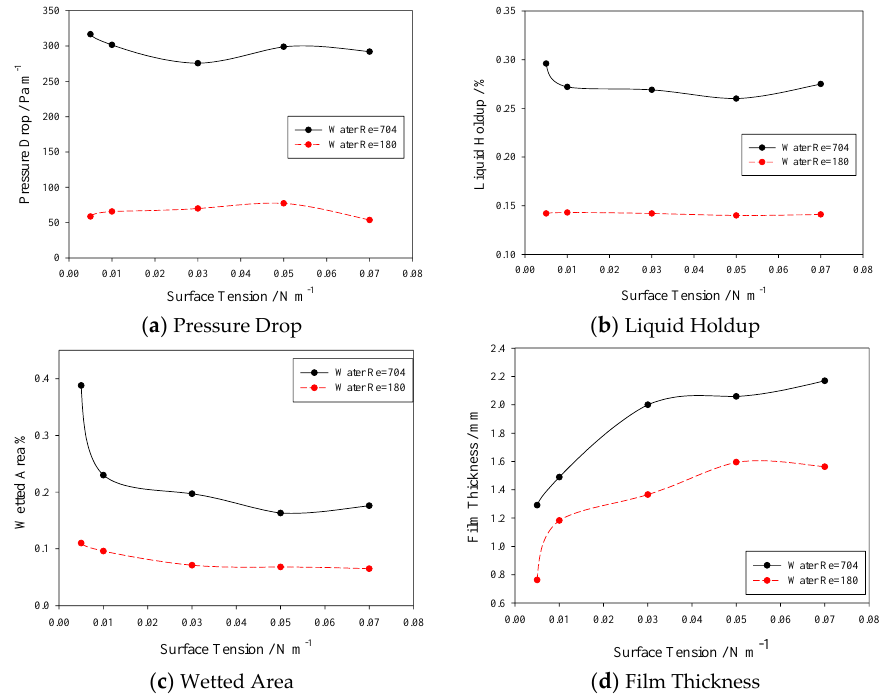
Figure 12. Influence of surface tension on pressure drop, liquid holdup, wetted area, and film thickness.